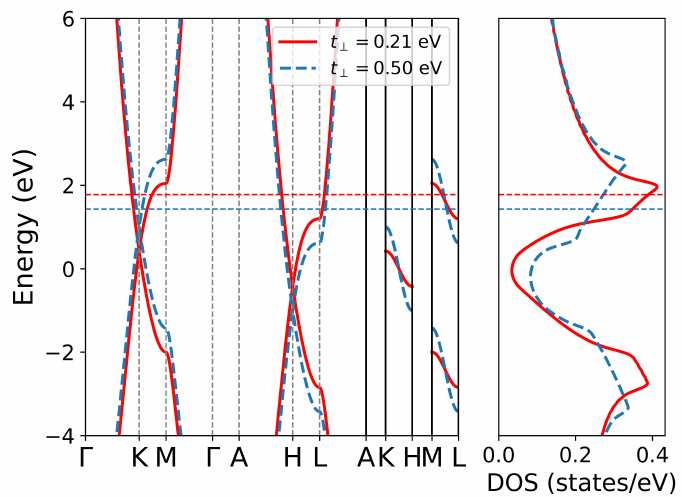
Figure 6. Band structure and density of states (DOS) at different interlayer hopping (red line for t ⊥ = 0.21 eV with E F = 1.555 eV and blue dashed line for t ⊥ = 0.50 eV with E F = 1.428 eV). The interlayer distance is fixed at 3.70 Å and the carrier density is fixed at 1.17 × 10 22 cm − 3 .